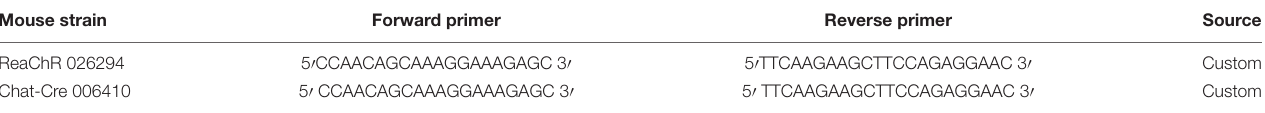
TABLE 1 | PCR primers used to genotype mouse